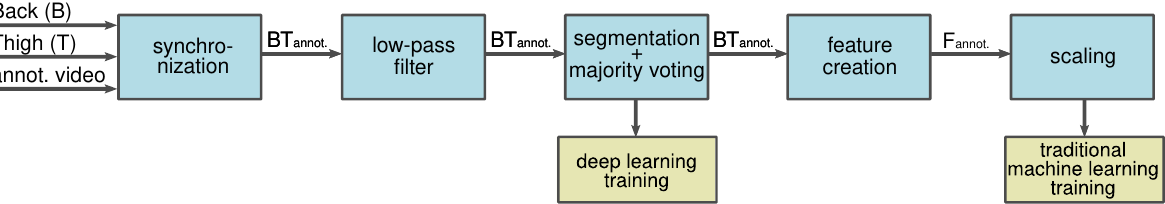
Figure 5. This figure illustrates the five preprocessing steps we performed. First, the two accelerometer signals and the annotated (denoted as annot.) video are time-synchronized. Second, a 20 Hz low-pass filter is applied to the annotated acceleration signals. Third, each signal is segmented into one-second windows, and a majority label voting is used. These windows are fed into the deep learning models for training. Fourth, 161 features (denoted as F) are computed for each window. Fifth, min–max feature scaling is applied. The resulting feature vectors are used to train the traditional machine learning